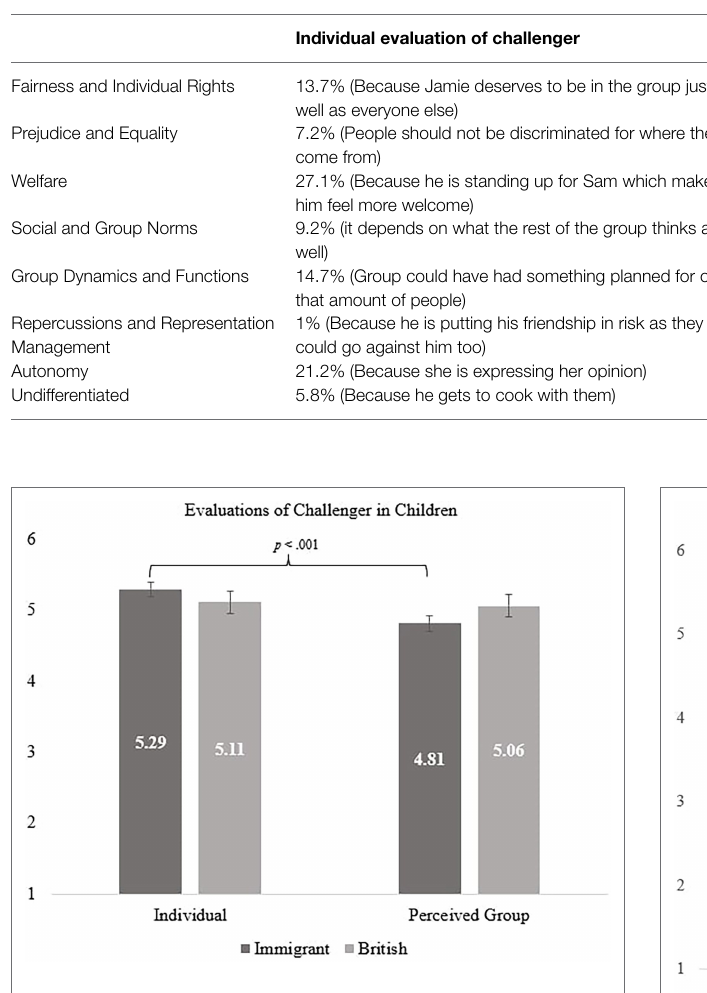
TABLE 1 | Frequencies (percentages) and examples for the reasoning.